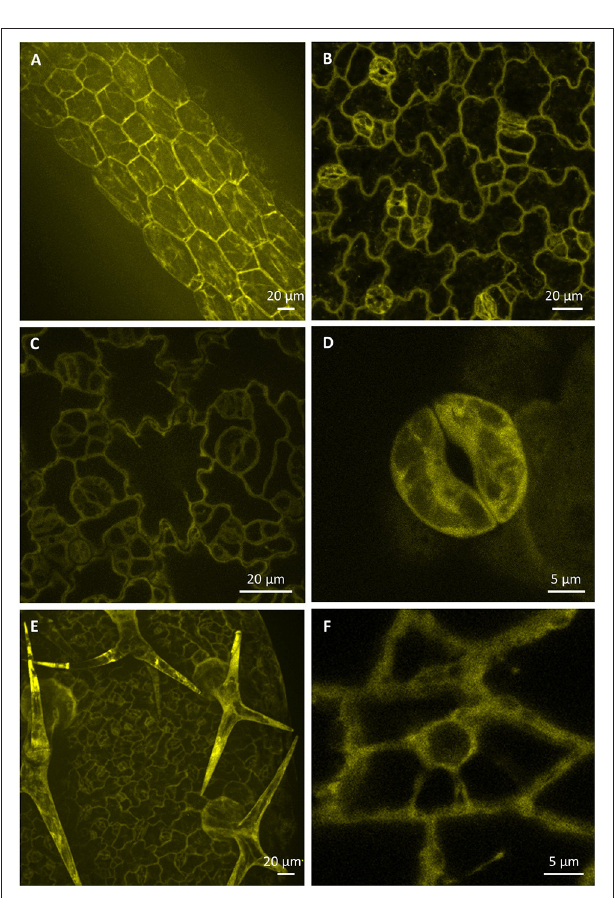
FIGURE 5 | Localization of PLD α 1-YFP driven by PLD α 1 own promoter in different aerial organs and tissues of Arabidopsis thaliana seedlings. Images were taken from different cell types of aerial tissues of living pld α 1-2 mutants stably expressing PLD α 1-YFP driven by its own promoter using confocal and spinning disk microscopy. Localization of PLD α 1-YFP in hypocotyl epidermal cells (A) , cotyledon epidermal cells and stomata (B) , leaf epidermal pavement cells and stomata guard cells (C) , leaf stoma guard cells (D) , leaf epidermal cells and trichomes (E) , and petiole epidermal cell (F) . Spinning disk microscopy (A,C,D) , confocal microscopy (B,E,F) .